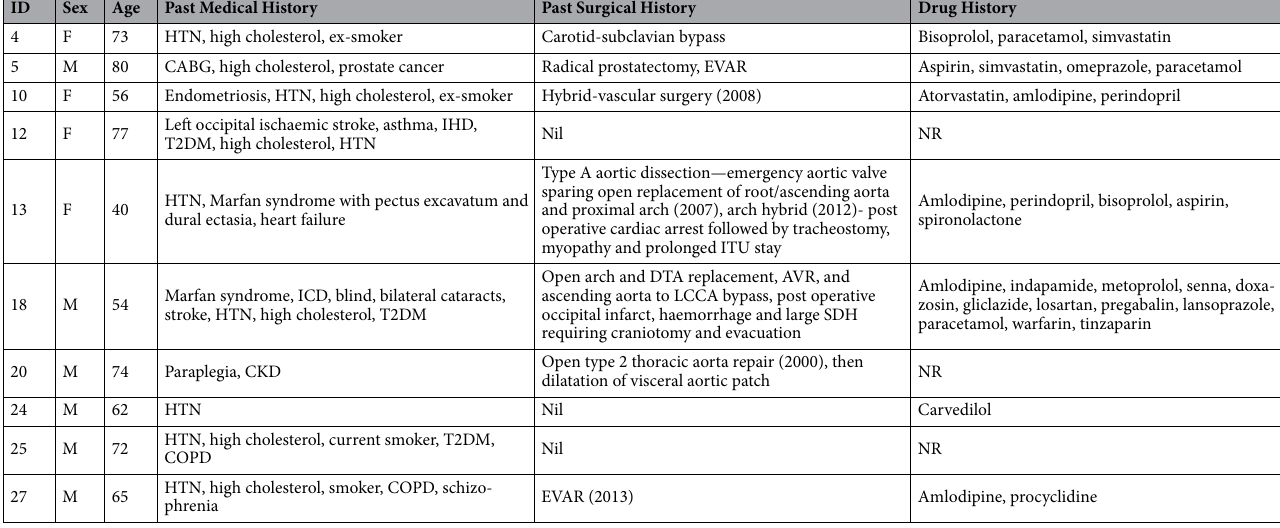
Table 1. Demographic and Pre-operative Information. AVR Aortic valve replacement, CKD Chronic kidney disease, CABG Coronary artery bypass graft, COPD Chronic obstructive pulmonary disease, DTA Descending thoracic aorta, EVAR Endovascular aneurysm repair, HTN Hypertension, ICD Implantable Cardioverter Defibrillator, IHD Ischaemic heart disease, ITU Intensive therapy unit, LCCA left common carotid artery,